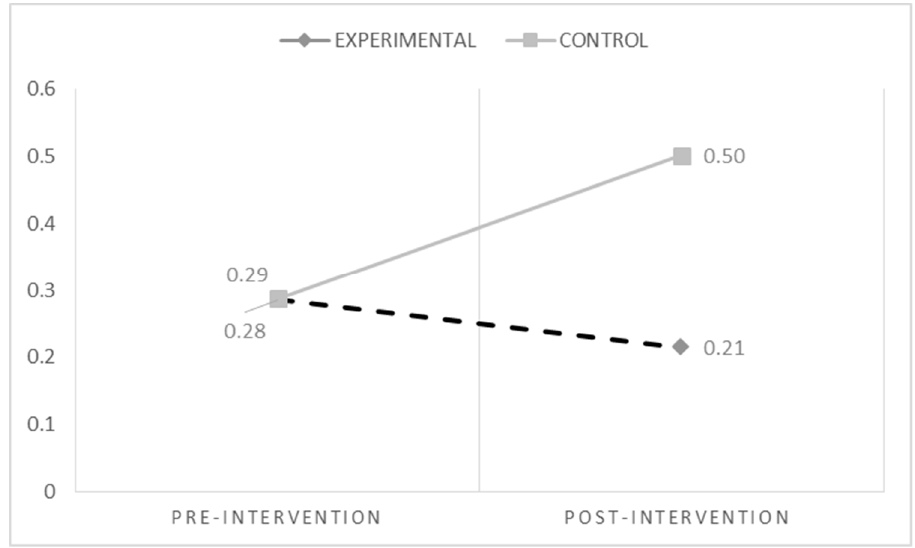
Figure 2. Changes in cyberbullying over time.